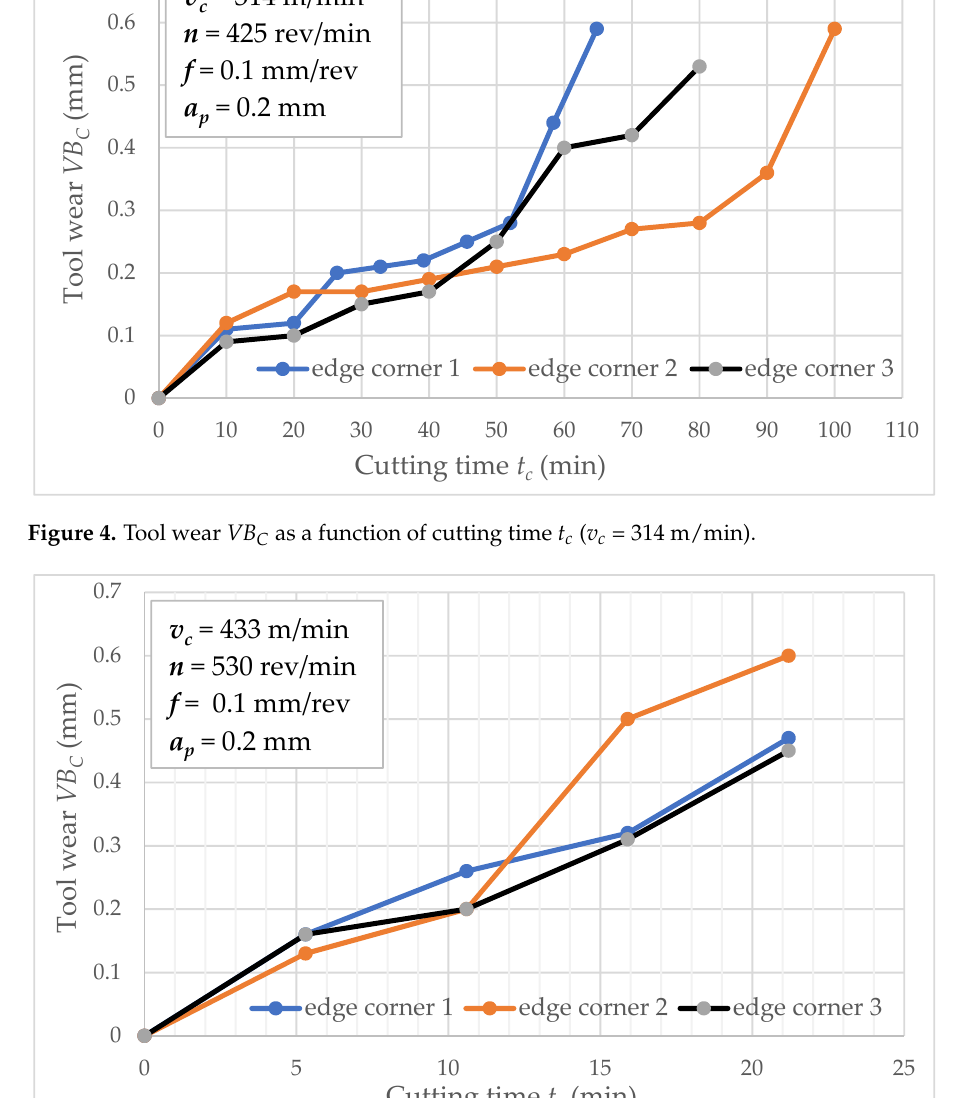
Figure 5. Tool wear VB C as a function of cutting time t c ( v c = 433 m/min).